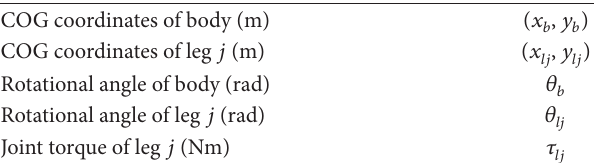
Table 2: Variables of the rolling huntsman-spider-inspired quadruped robot ( 𝑗 = 1 ,